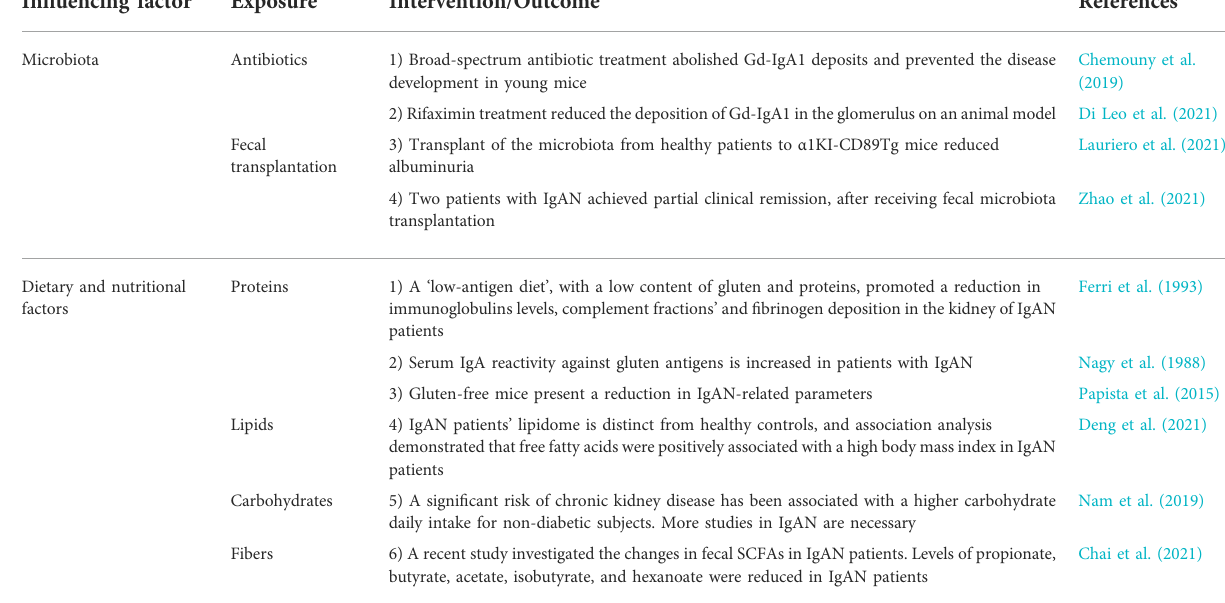
TABLE 1 Intestinal-derived factors contributing to the IgAN